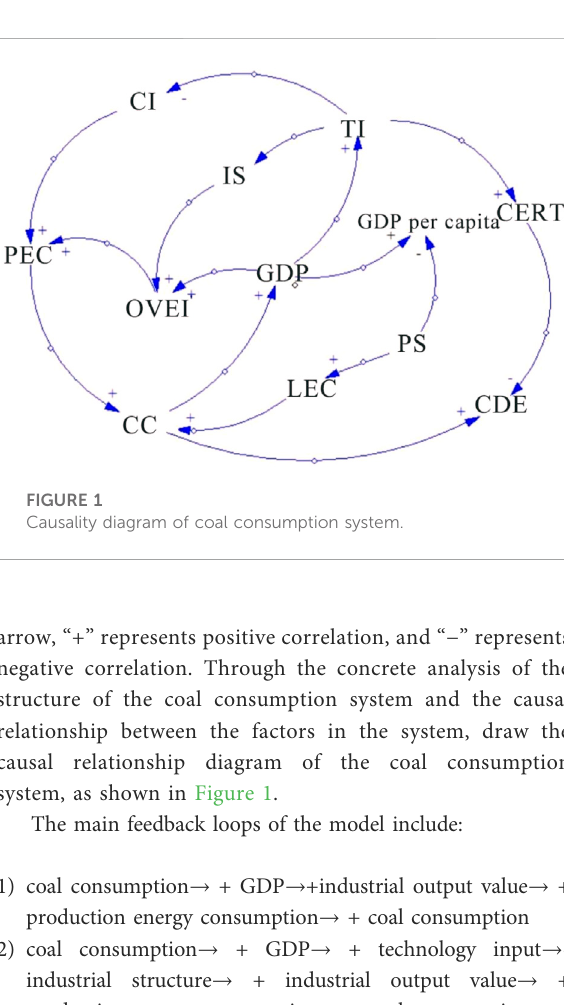
arrow, “ + ” represents positive correlation, and “ − ” represents negative correlation. Through the concrete analysis of the structure of the coal consumption system and the causal relationship between the factors in the system, draw the causal relationship diagram of the coal consumption system, as shown in Figure 1.